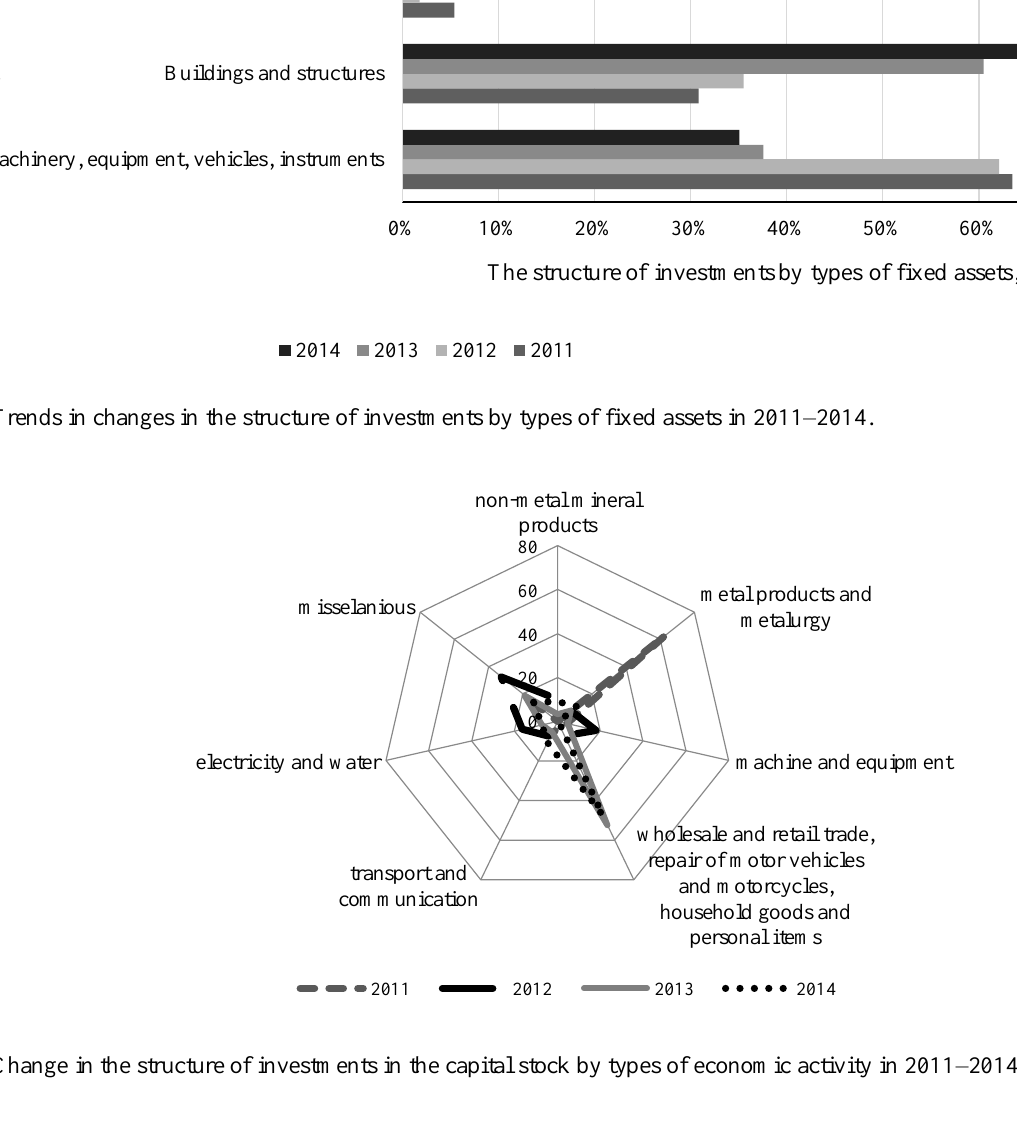
Fig. 3. Change in the structure of investments in the capital stock by types of economic activity in